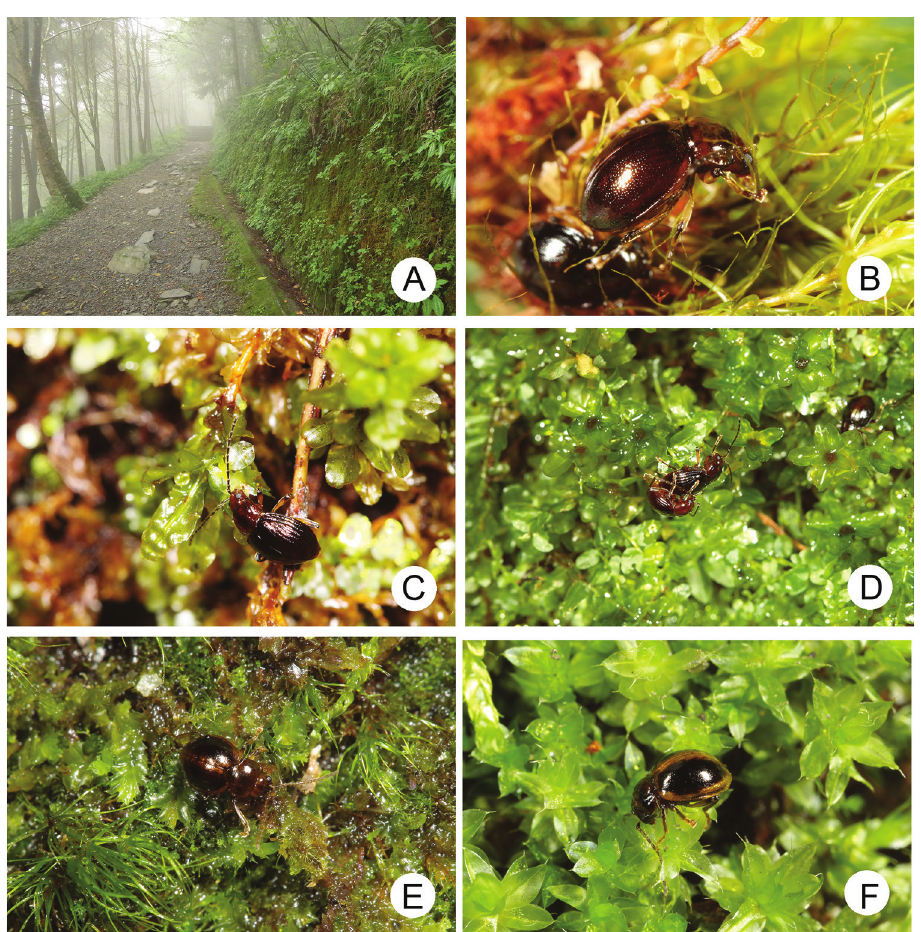
Figure 1. Habitat photographs. A microhabitat for Taiwanoshaira taipingshanensis sp. nov. and T. tsoui sp. nov. at Yuanyang Lake ( 鴛鴦湖 ) B active adults of T. chujoi comb. nov. inside moss cushions at Pilu ( 畢祿 ) C adult of T. taipingshanensis sp. nov. feeding on leaves of Plagiomnium vesicatum at Yuanyang Lake ( 鴛鴦湖 ) D adults of T. taipingshanensis sp. nov. mating at Yuanyang Lake ( 鴛鴦湖 ) E adult of T. tsoui sp. nov. at Hsiaofengkou ( 小風口 ) F adult of T. tsoui sp. nov. at Meifeng ( 梅峰